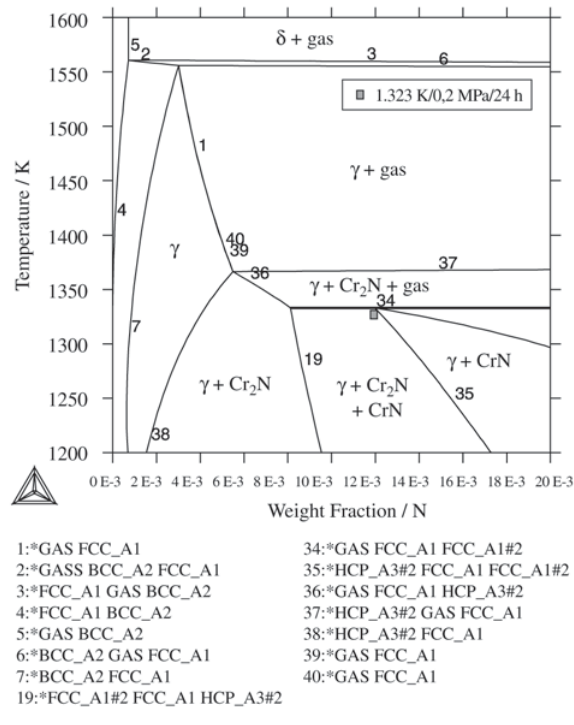
Figure 4. Isopleth of the Fe- 13% Cr – N system for 0.20 MPa N pressure. The small square indicates the GDOS measured surface nitrogen content of an AISI 410 S stainless steel after 24 hours of exposure to a 0.20 MPa N atmosphere at 1323 K. 2